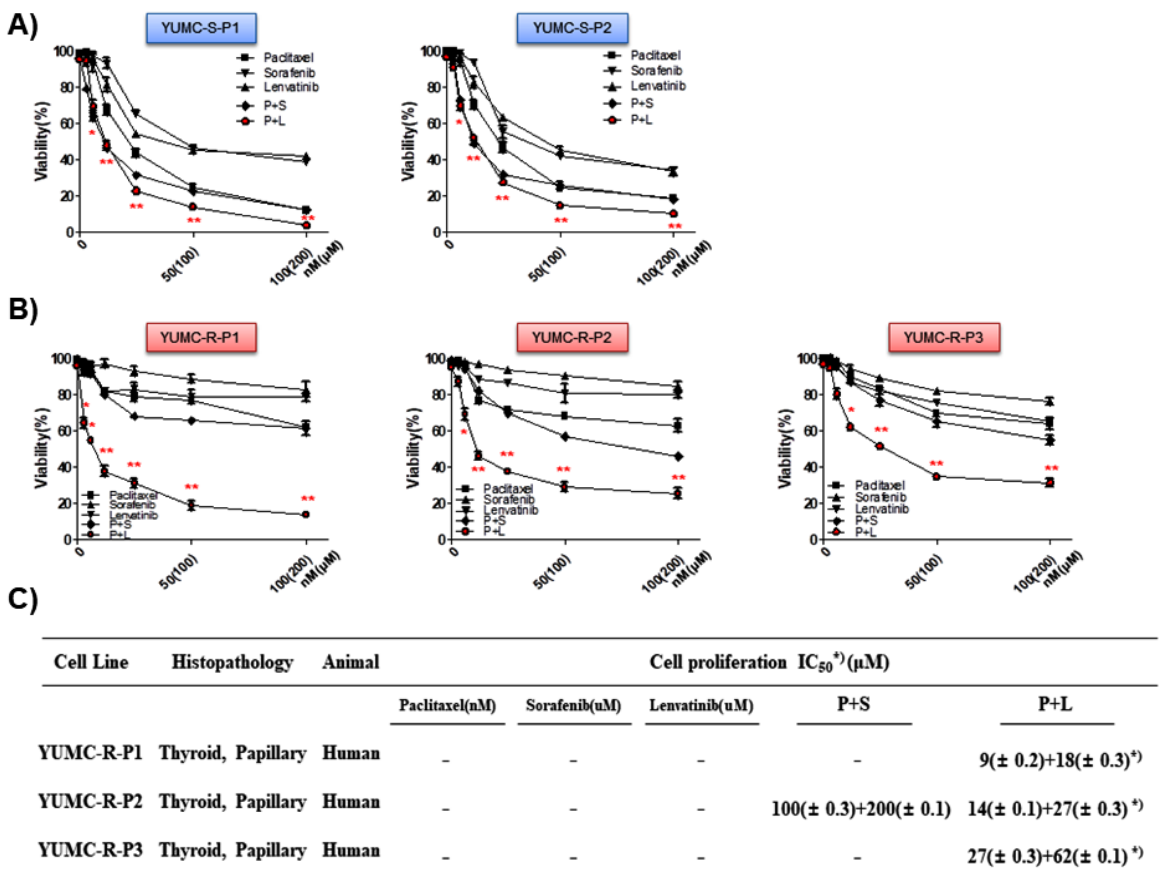
Figure 3. Synergistic anti-cancer effect of paclitaxel and lenvatinib in anti-cancer drug-sensitive and drug-resistant papillary thyroid cancer (PTC) cells. Cell viability of anti-cancer drug-sensitive (( A ), YUMC-S-P1 and YUMC-S-P2) and -resistant (( B ), YUMC-R-P1, YUMC-R-P2, and YUMC-R-P3) PTC cells with paclitxel, sorafenib, and levatinib combined or with each agent alone. Points indicate the mean percentage of the values observed in solvent-treated control. All experiments were performed at least thrice. Data represent mean ± standard deviation. * p < 0.05 and ** p < 0.01 versus control. ( C ), Half-maximal inhibitory concentration (IC 50 ) values for the combination of sorafenib and lenvatinib in anti-cancer drug-sensitive and -resistant PTC cells. Each data point signifies the mean of three independent MTT assays, performed in triplicate. SEM, standard error of the mean; MTT, 3-(4,5-dimethylthiazol-2-yl)-2,5-diphenyltetrazolium bromide. The asterisk indicates the lowest half-maximal inhibitory concentration.